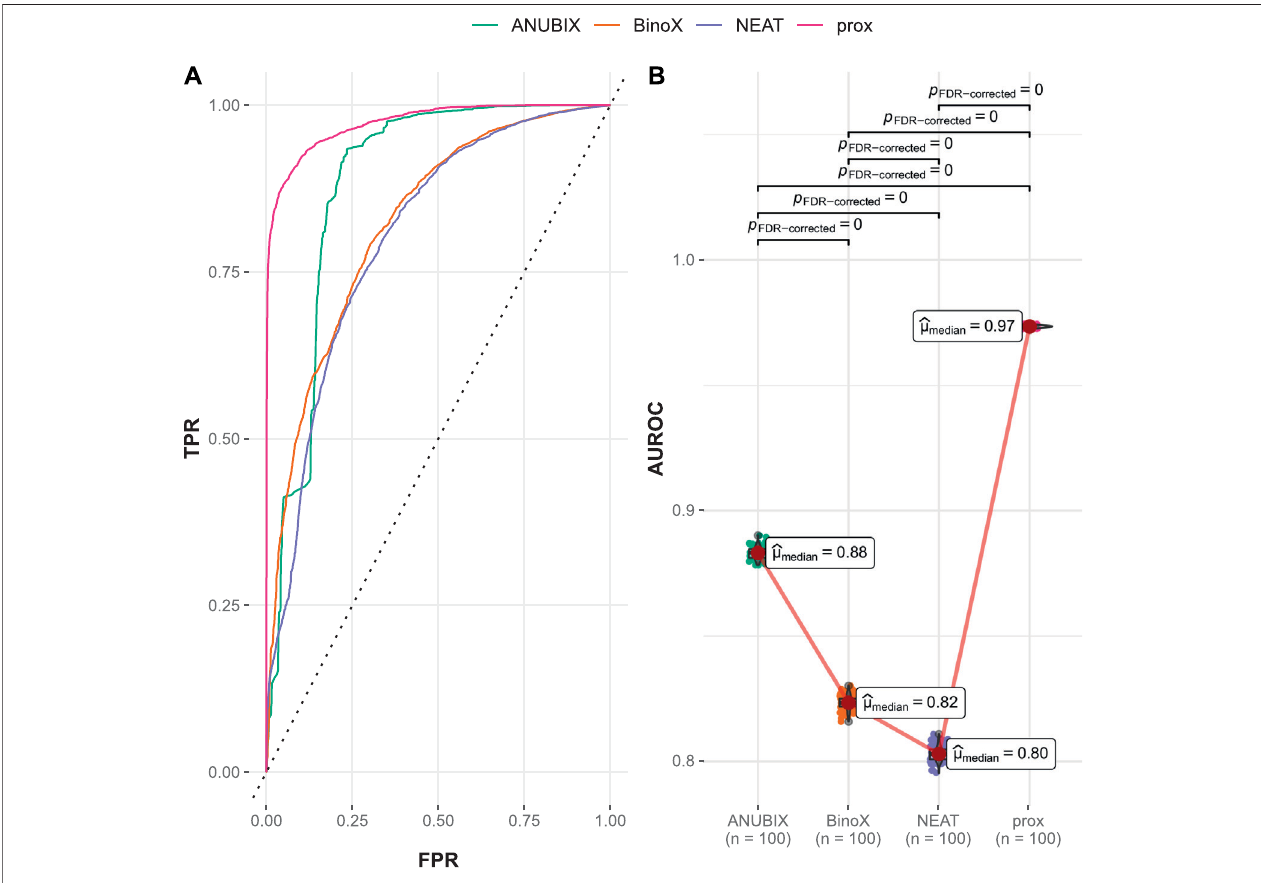
FIGURE8| Drug – drugsimilarity – basedperformanceontheFCbench.Performanceofthedifferentdrugrepurposingtools:ANUBIX(green),BinoX(orange),NEAT (purple), and proximity (prox, pink) on (A) ROC curves, where the dotted line represents random prediction, and (B) AUROC using sampled sets from the benchmark containingequalnumbersofpositiveandnegativedrug – diseasecombinations.ThepairwiseWilcoxonranksumtestwasusedtoassessthesigni fi canceofdifferenceon AUROC. FDR-corrected p -values were obtained using the Benjamini – Hochberg procedure.